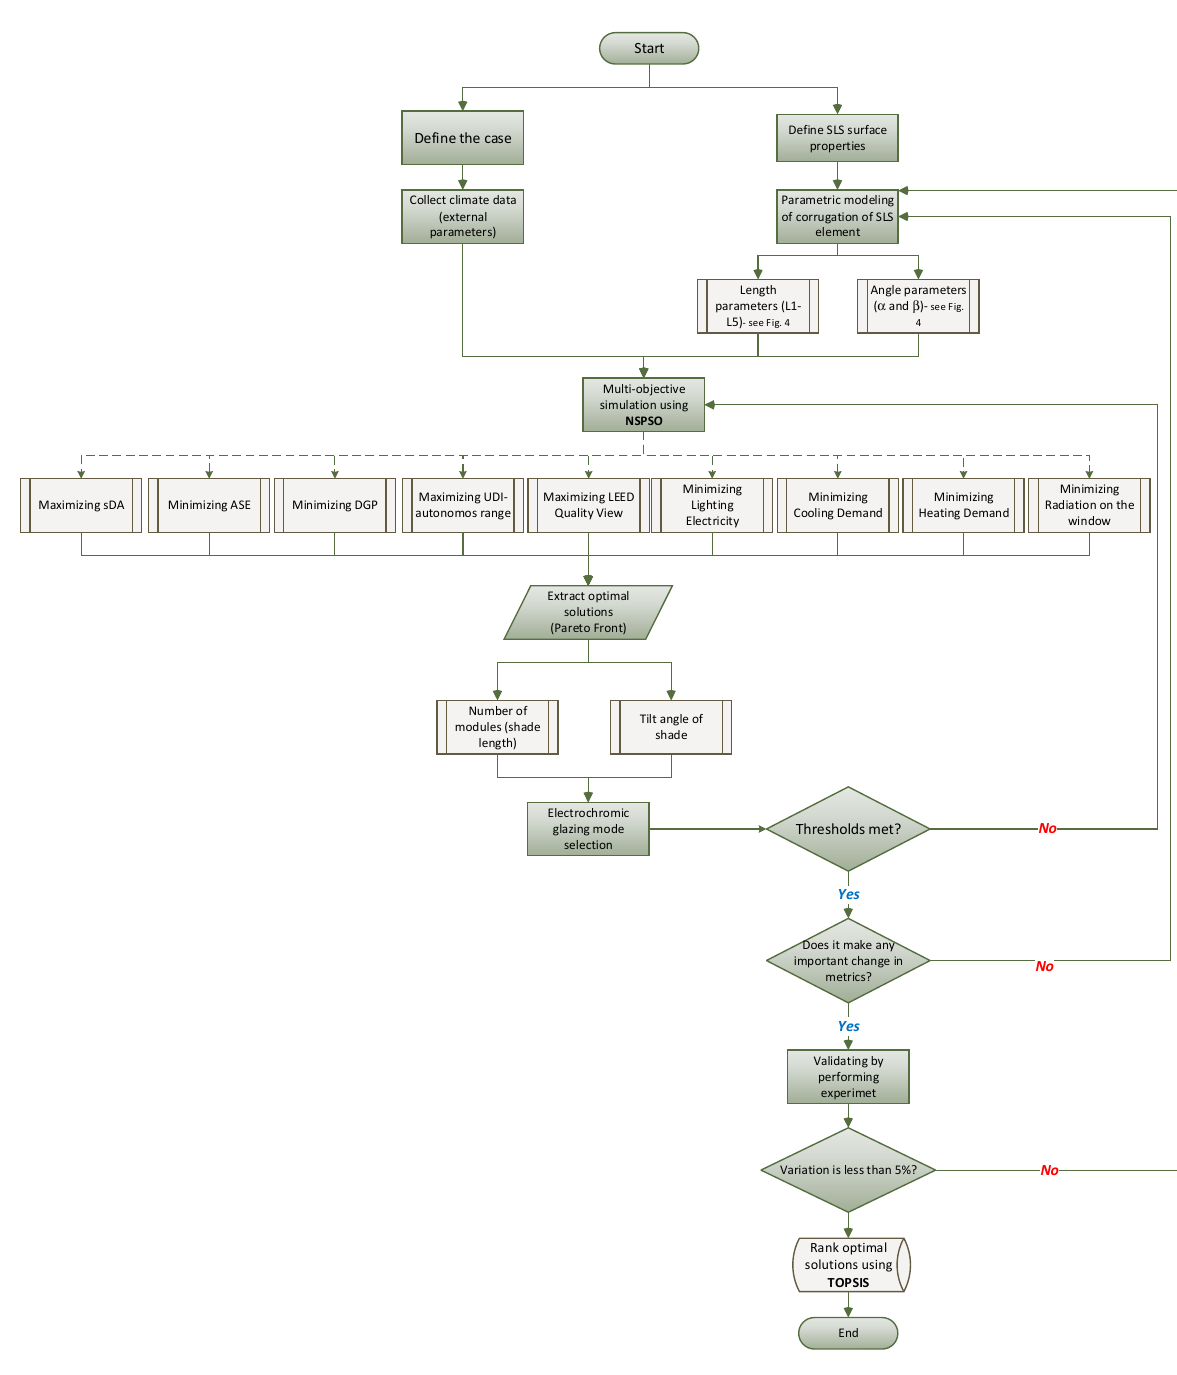
Figure 3. Block diagram of the solution- fi nding process.